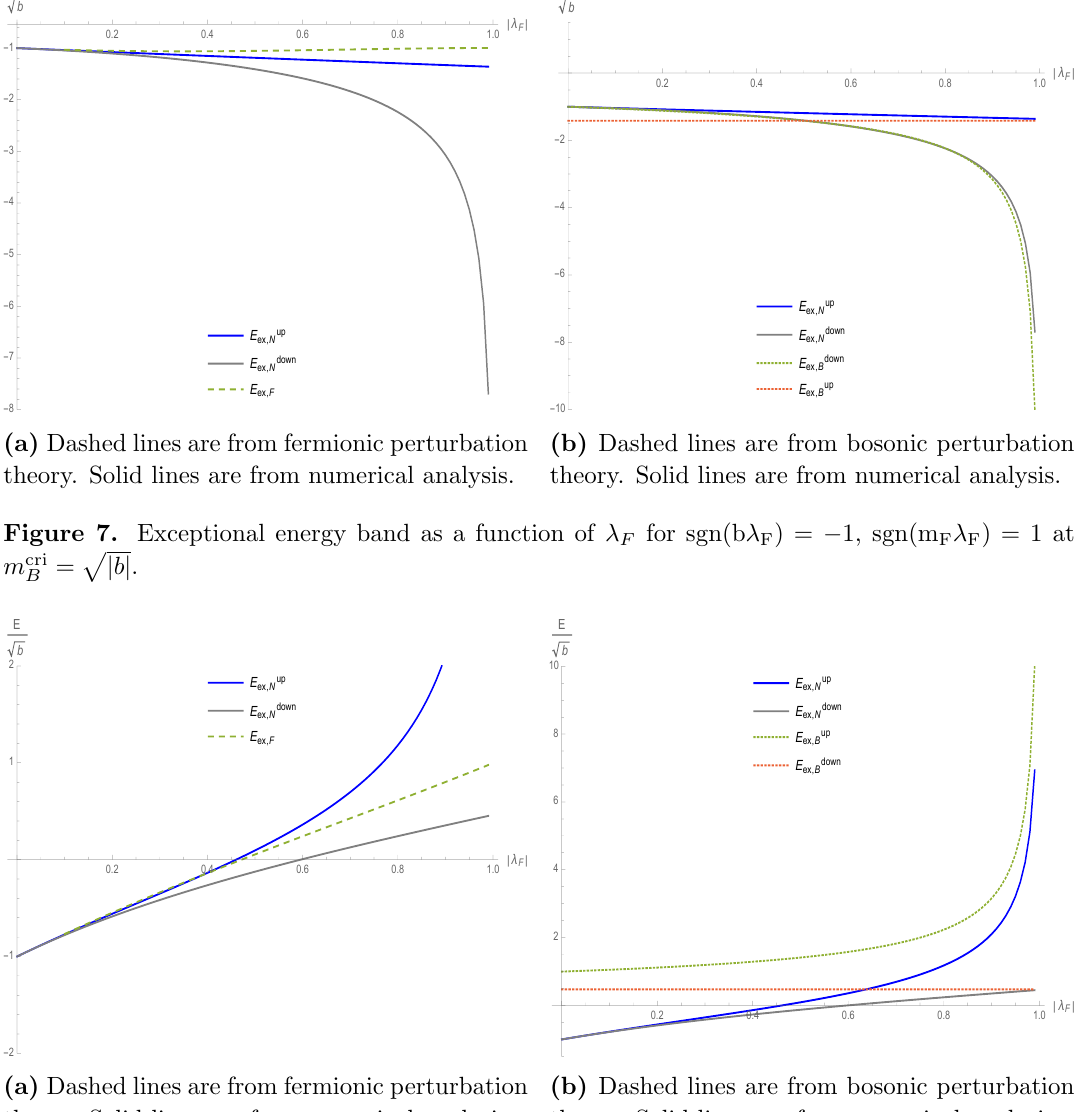
(a) Dashed lines are from fermionic perturbation theory. Solid lines are from numerical analysis. Figure 8. Exceptional energy band as a function of (cid:21) F for sgn(b (cid:21) F ) = 1, sgn(m F (cid:21) F ) = (cid:0) 1 at p m cri = (cid:0) j b j B